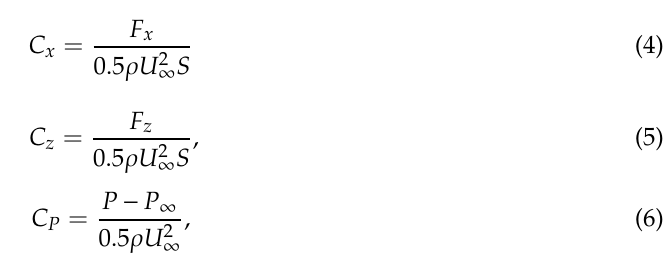
Figure 6. Mesh sensitivity: time-averaged of ( a ) U and ( b ) pressure.